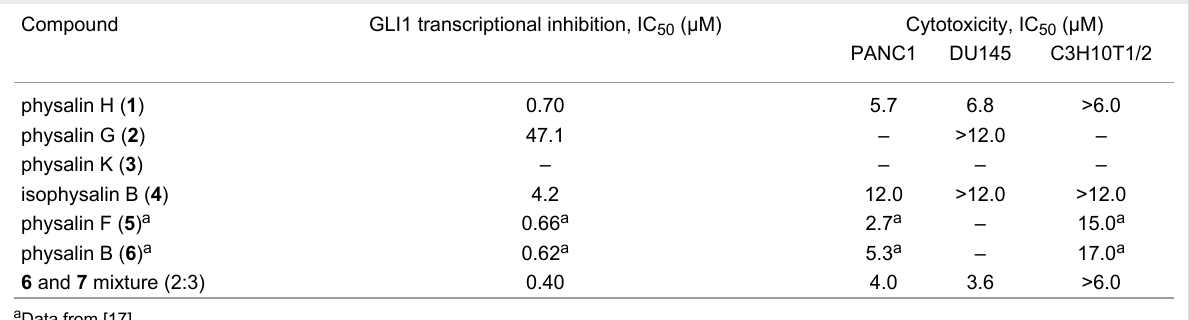
Table 1: GLI1 transcriptional activity and cytotoxicity.